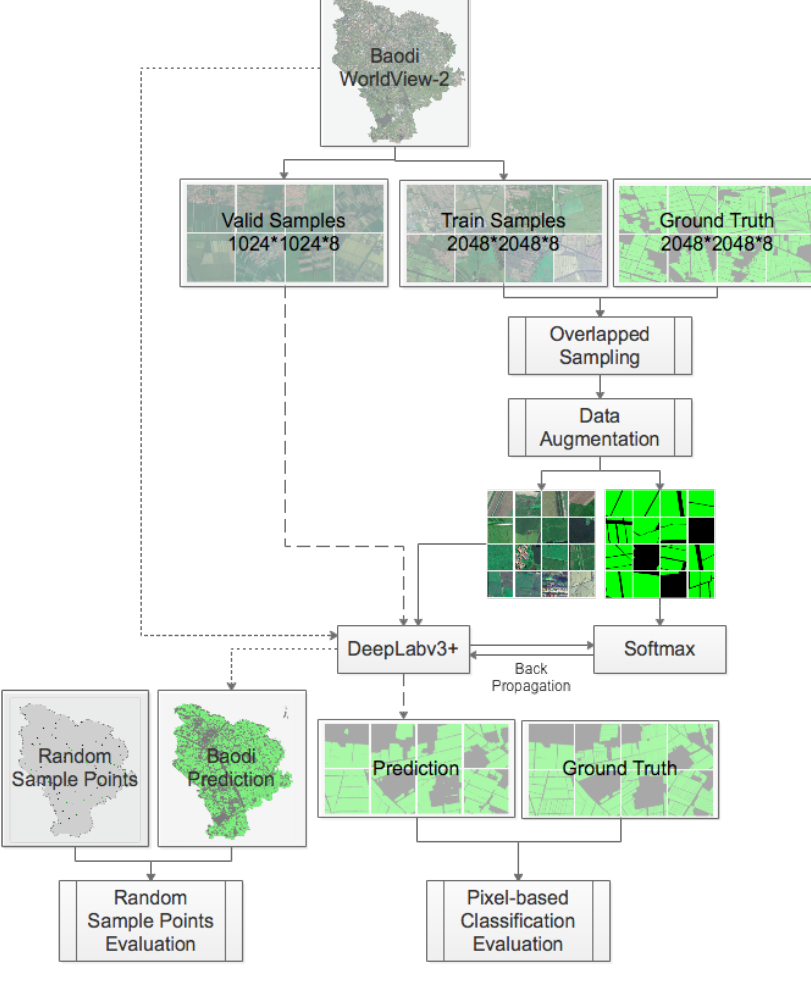
Figure 2. Workflow for mapping crop area (CA) using DeepLabv3+.